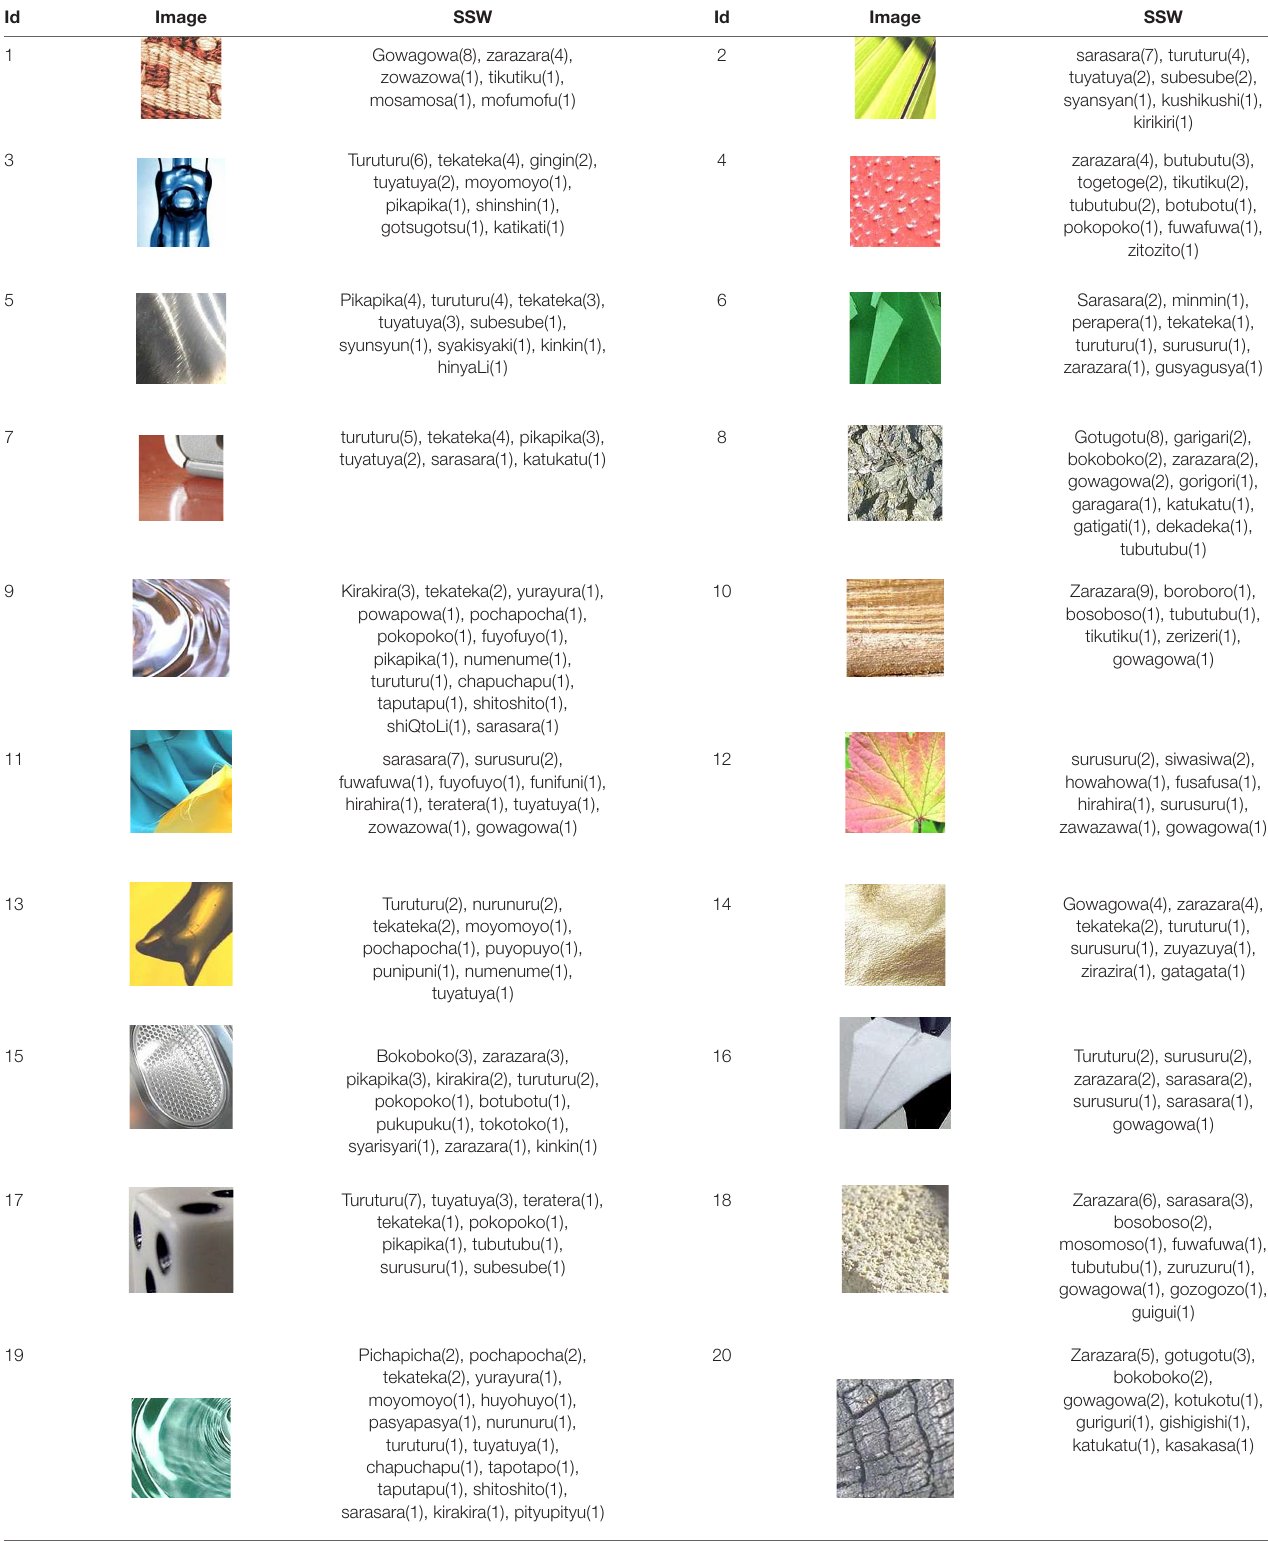
TABLE 1 | SSWs described freely by the participants in the experiment conducted in section “System That Expresses Texture Using Sound-Symbolic Words Corresponding to the Texture-Based Flickr Material Database”. Id